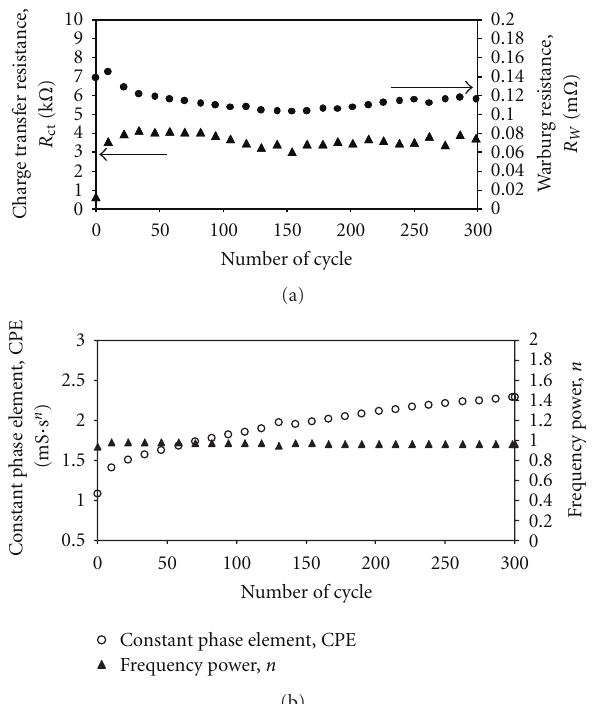
Figure 6: (a) Charge-transfer and Warburg resistances, and (b) constant phase element (CPE) and frequency power ( n ), at di ff erent charge/discharge cycle.